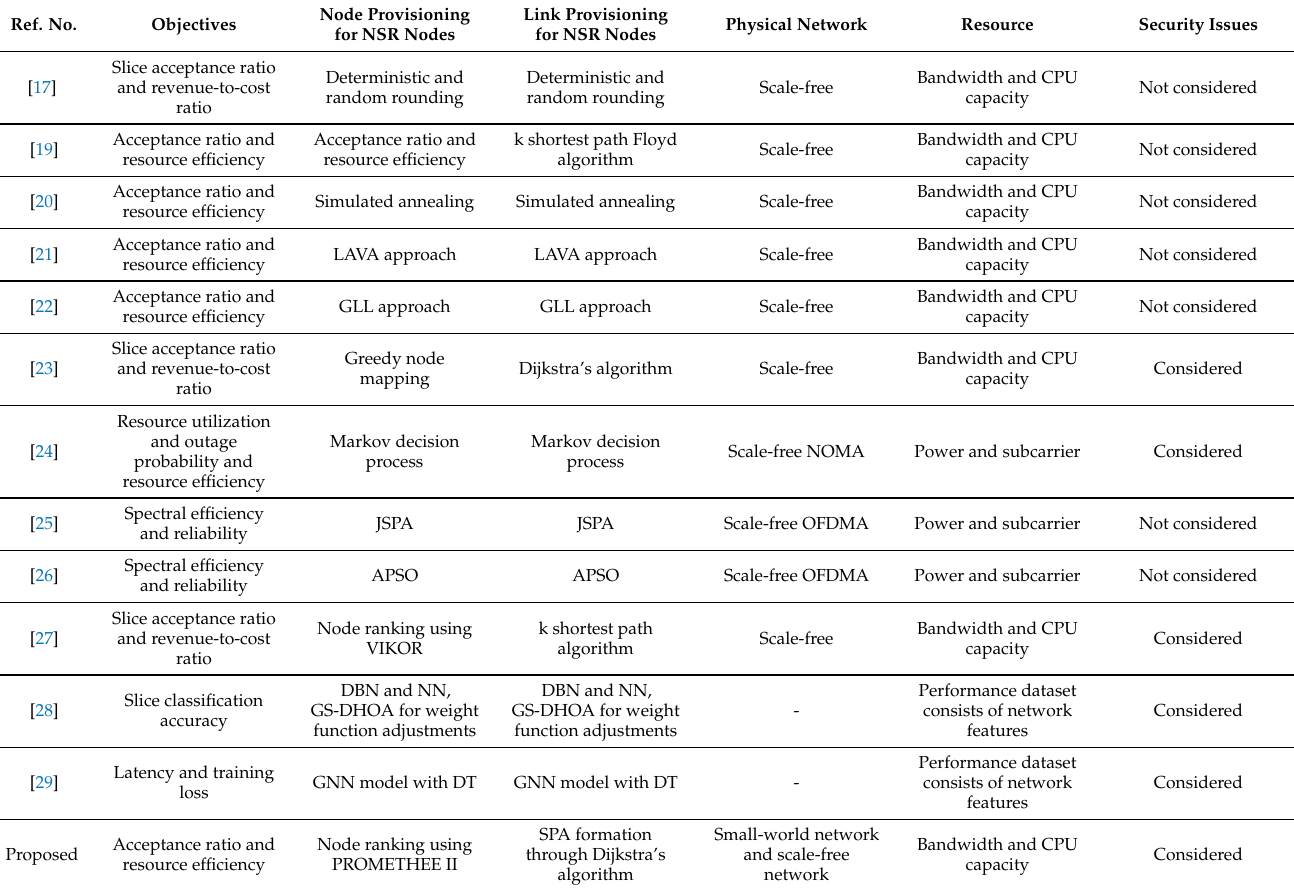
Table 1. Summary of